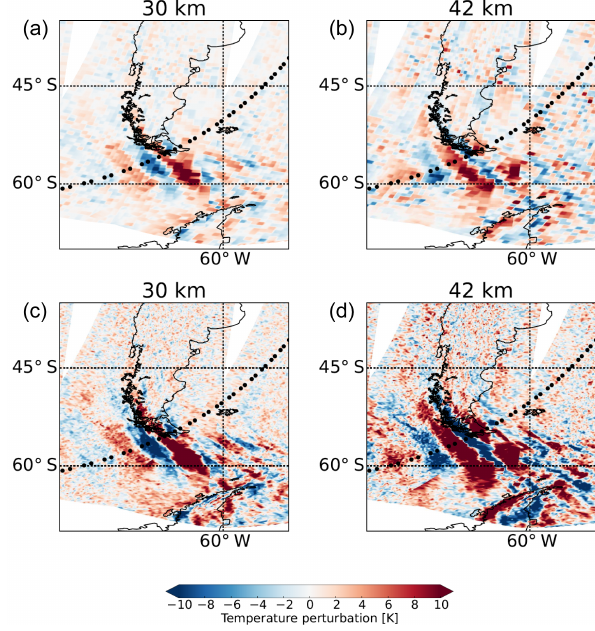
Figure 4. Temperature perturbations from AIRS retrievals on 29 September 2006 at about 03:00UTC at 30km (a, c) and 42km (b, d) for a mountain wave event near Tierra del Fuego. (a, b) AIRS operational retrieval. (c, d) AIRS high-resolution retrieval. Black circles indicate the locations of HIRDLS profiles.